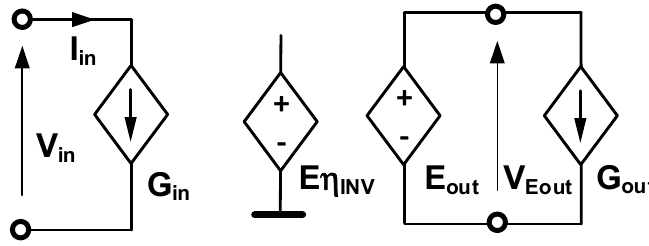
Figure 3. Network representation of the inverter model .